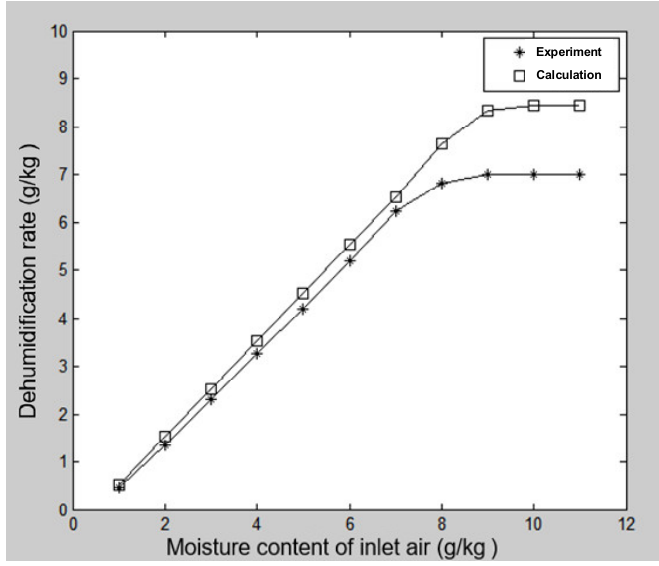
Figure 19. Comparison between calculated and experimental values of desiccant capacity of runner.